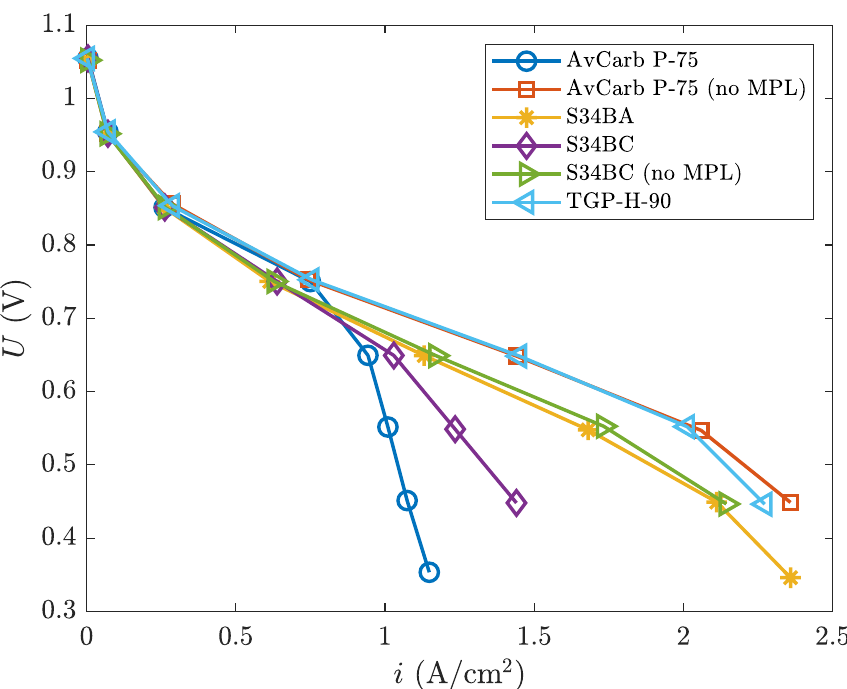
Figure 3. Polarization curves for each of the commercial GDLs in study, with and without MPL. In terms of the PEMFC performance, three wel-differentiated behaviors can be inferred from Figure 3. First, the case of the poorest performance (i.e., the case providing the smallest current density) corresponding to the AvCarb GDL+MPL assembly is